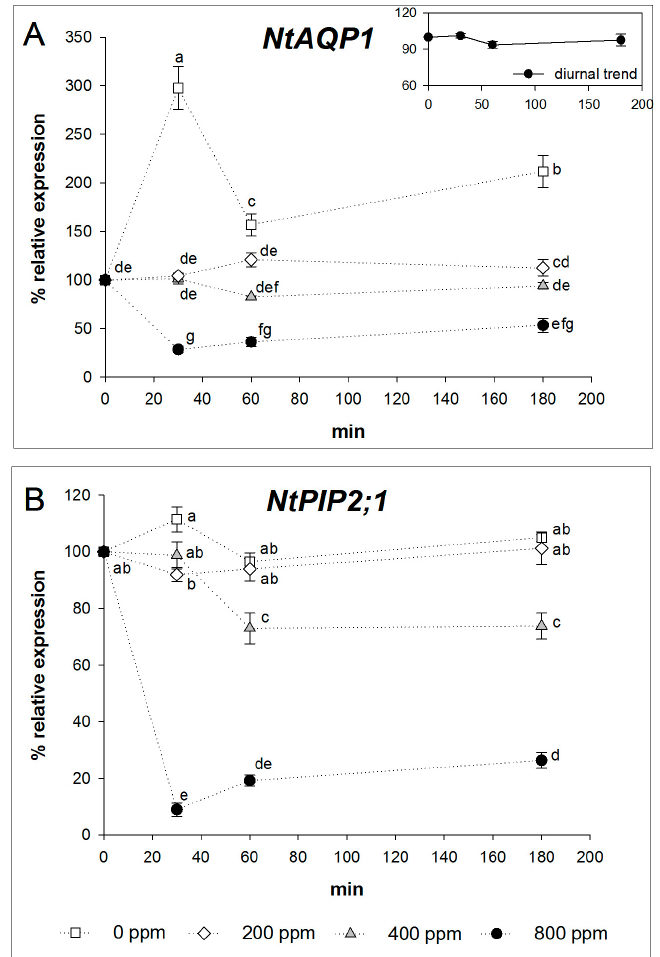
Figure 2. Time course of ( A ) the Nicotiana tabacum aquaporin 1 ( NtAQP1 ) transcript level and ( B ) the Nicotiana tabacum plasma membrane intrinsic protein 2;1 ( NtPIP2;1 ) transcript level in tobacco leaves treated with air containing different CO 2 concentrations. Samples were taken at 0, 30, 60 and 180 min after starting treatment. Values represent expression relative to that observed in control plants (400 ppm CO 2 ) at time 0. In the A inset, the expression level of NtAQP1 at ambient [CO 2 ], during a time span of 4.5 h (from 10 a.m. to 2:30 p.m.) is displayed. The expression levels of the target genes were normalized using Elongation factor 1 α as internal control. Zero ppm CO 2 : black empty squares; 200 ppm CO 2 : grey empty diamonds; 400 ppm CO 2 : grey filled triangles; 800 ppm CO 2 : black filled circles; samples not subjected to imposed CO 2 : black filled triangles. The results are the averages of three independent biological samples ( error bars denote SE) for each treatment and time ( n = 3). Different letters denote statistically significant differences by Tukey’s test.